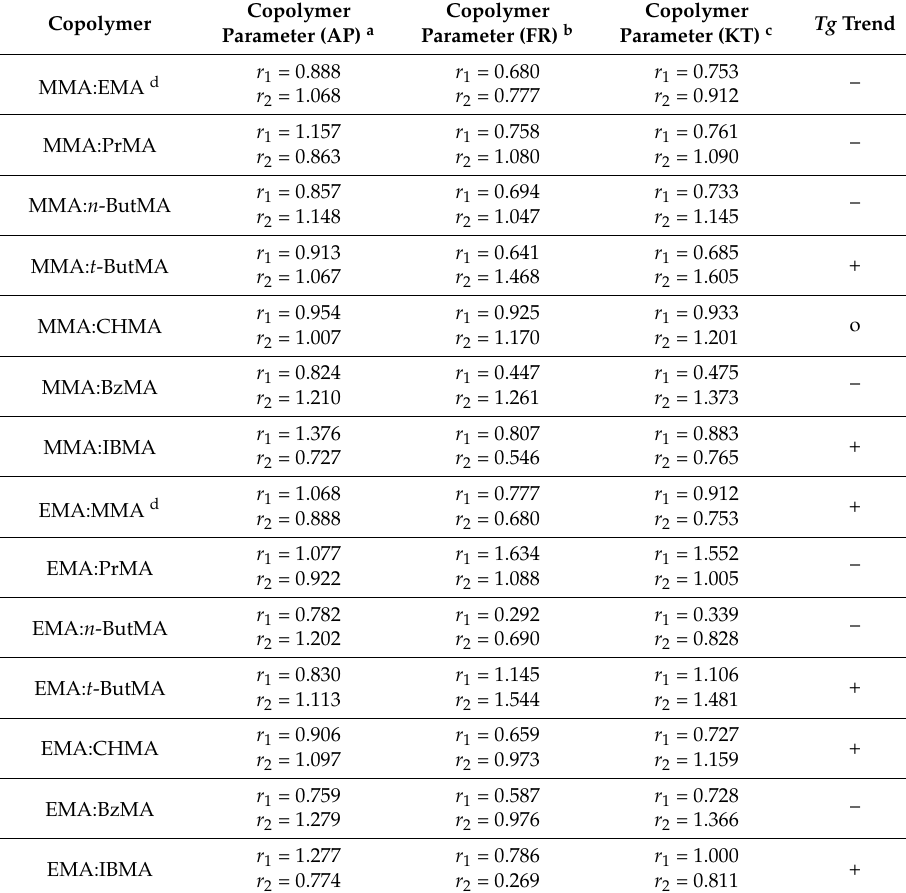
Table 1. Calculated copolymerization parameters from literature-based Q , e -Values (AP) and from experimental data evaluated with calculations following Fineman-Ross (FR) and Kelen-Tüdös (KT). General Tg trend for an uprising commoner